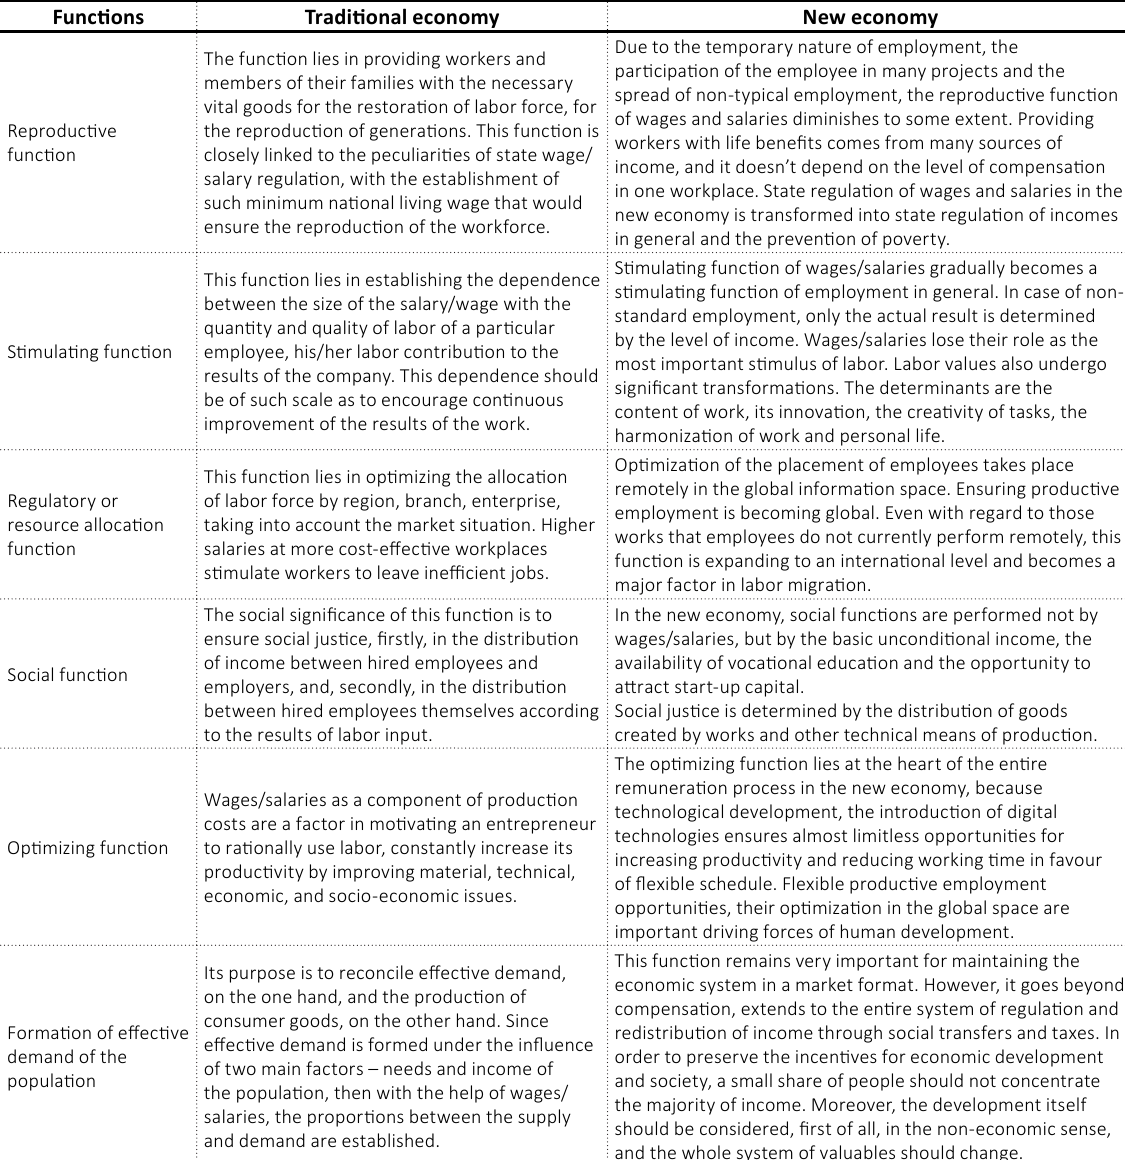
Table 2. Salary and wage functions in traditional and new